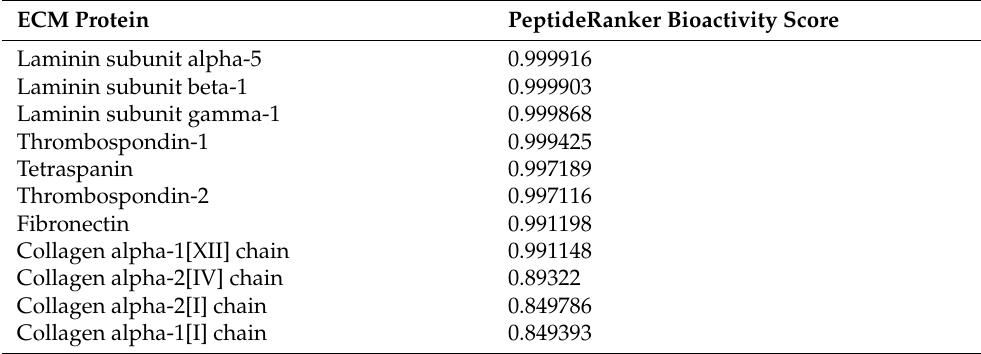
Figure 3. Categorization of ECM proteins found in the MMSC ECM nanoparticles. PeptideRanker indicated that the MMSC ECM nanoparticles were composed of several protein subunits that potentially could possess bioactivity, including peptide sequences derived from collagen, fibronectin, and laminin (Table 1). In particular, cationic sequences from fibronectin and the beta-1 chain of laminin are known to have antimicrobial effects. The membrane protein tetraspanin was found in the ECM proteins, which have been shown to have antimicrobial activity. Thrombospondin-1 and thrombospondin-2 were found as well. Hydrophobic regions from thrombospondins have been proven to have antimicro- bial activity against both gram-positive and gram-negative bacteria [23]. Glycoprotein fibulin-1 was found in the MMSC ECM nanoparticles known to encourage lung fibroblast proliferation and attachment [31]. Table 1. Selected MMSC ECM nanoparticle proteins and their predicted bioactivity ranking from PeptideRanker. Peptides are listed from the highest bioactivity score to the